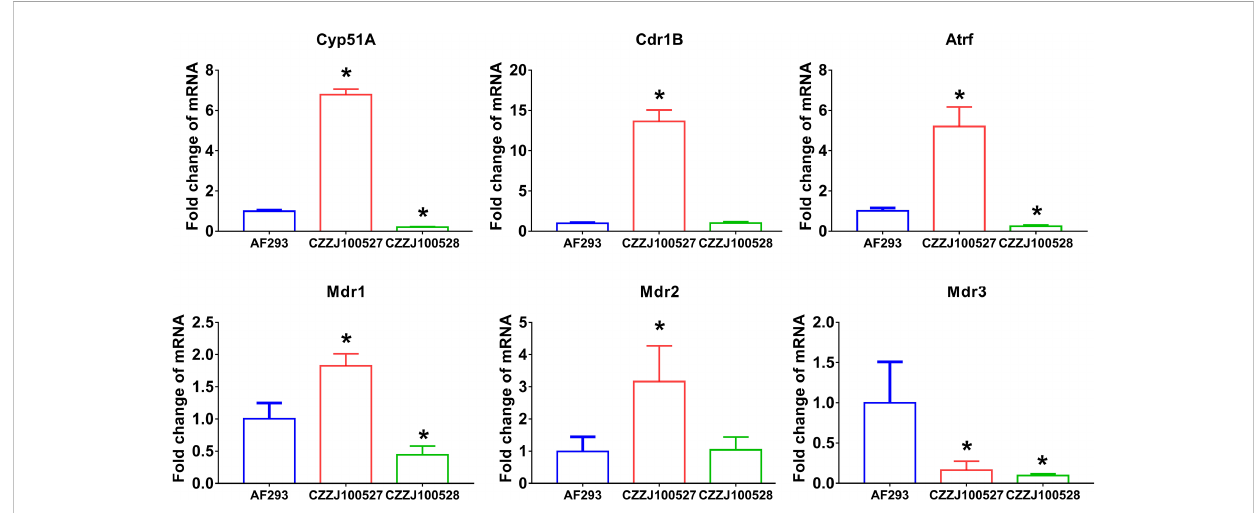
FIGURE 1 Expression of genes associated with triazole resistance mRNA levels of Cyp51A, Cdr1B, AtrF, Mdr1, Mdr2, and Mdr3 in AF293, CZZJ100527, and CZZJ100528 were determined. The genes of interest are expressed as fold change relative to that of AF293. * P < 0.05 vs. AF293